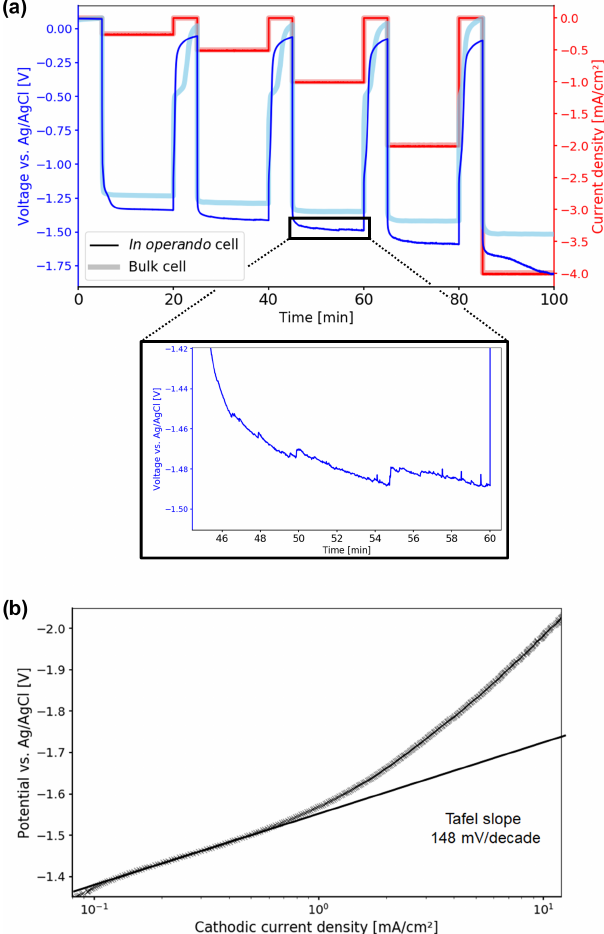
Figure 6. (a) Time-dependent potential curves during the chronopotentiometry measurement. Electrolytic reduction of CO 2 starts at − 1.33V vs. Ag / AgCl for the in operando cell. Com- pared to the bulk cell, higher overpotentials are observed. Start- ing at 1mAcm − 2 , oscillations and increased noise appear, which are caused by stuck product gas bubbles. (b) Tafel plot of the elec- trolytic CO 2 reduction in the in operando electrolysis cell. The Tafel slope was determined in the low current density region as 148mV per decade, resulting in a transfer coefficient of 0.38 at 10 ◦